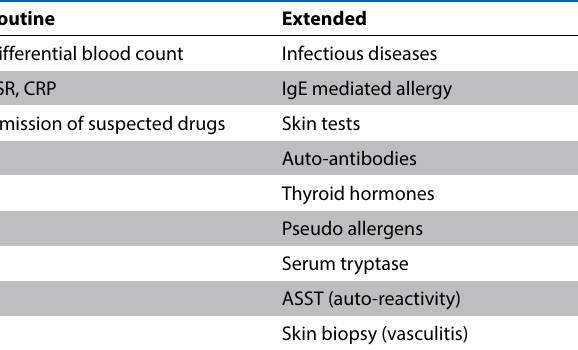
Table 1: Recommended investigation of CSU according to EAACI/ GA 2 LEN/EDF/WAO 2013 guideline